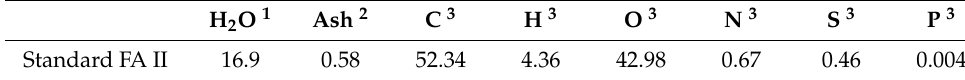
Table 1. The elemental compositions in %( w / w ) of SRFA provided by